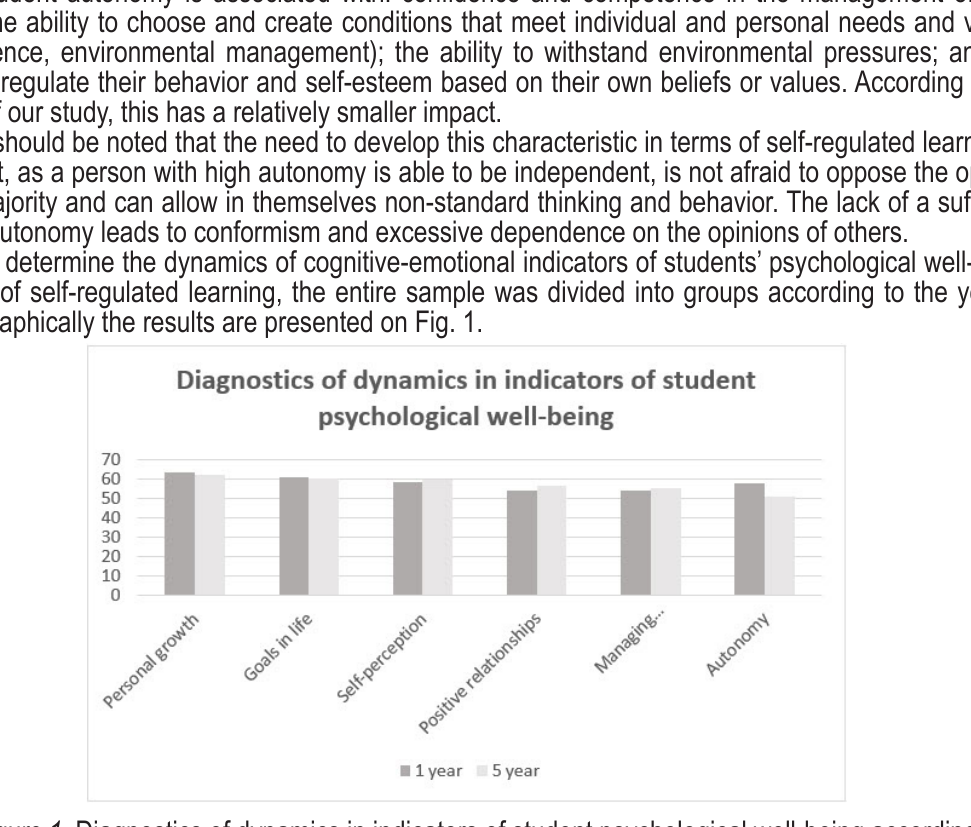
Figure 1. Diagnostics of dynamics in indicators of student psychological well-being according to K. Ryff’s “Scale of Psychological